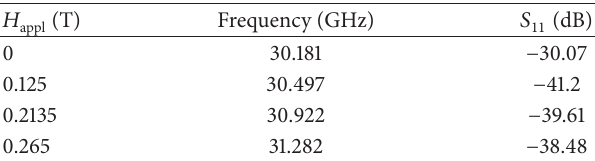
Table 1: Return loss and resonant frequency shift as result of ferrite substrate magnetic